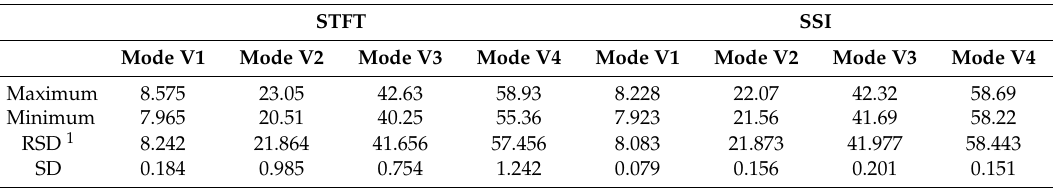
Table 5. Statistical analysis